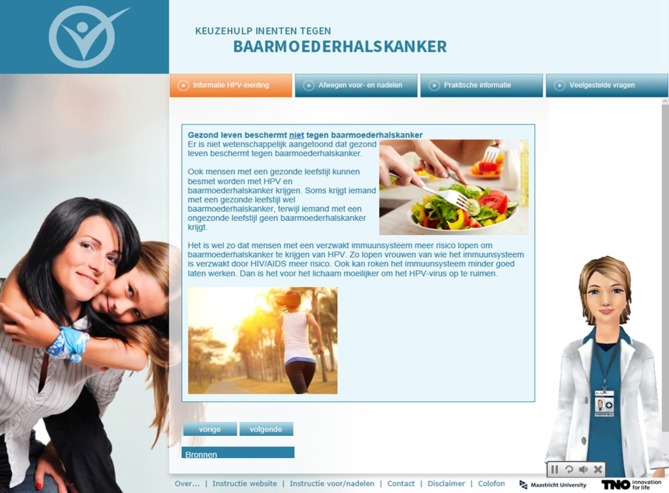
Screenshot of the doctor-like assistant providing feedback about the ineffectiveness of having a healthy life style (e.g., healthy eating, exercising) in protecting against cervical cancer with illustrations provided by a graphic designer.